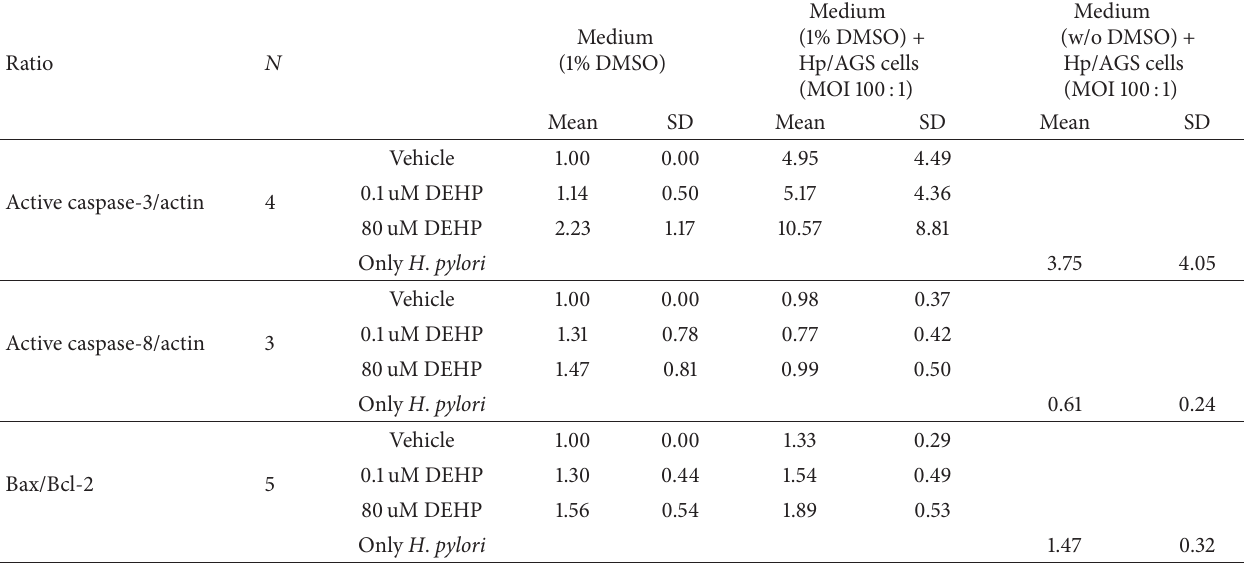
Table 1: Summary of apoptosis-related proteins expression ratio after DEHP alone or DEHP combined with H . pylori (MOI = 100: 1) treatment a